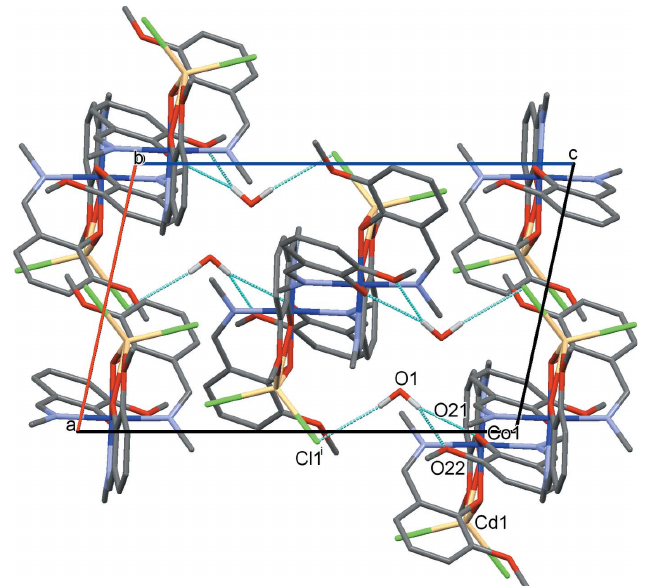
Figure 2 Crystal packing of ( 1 ) showing columns of CoCd L 3 Cl 2 molecules joined by hydrogen-bonding interactions through the solvent water molecules along [101]. The symmetry code is as in Table 2. Hydrogen bonds are shown as blue dashed lines. Only water H atoms are shown.